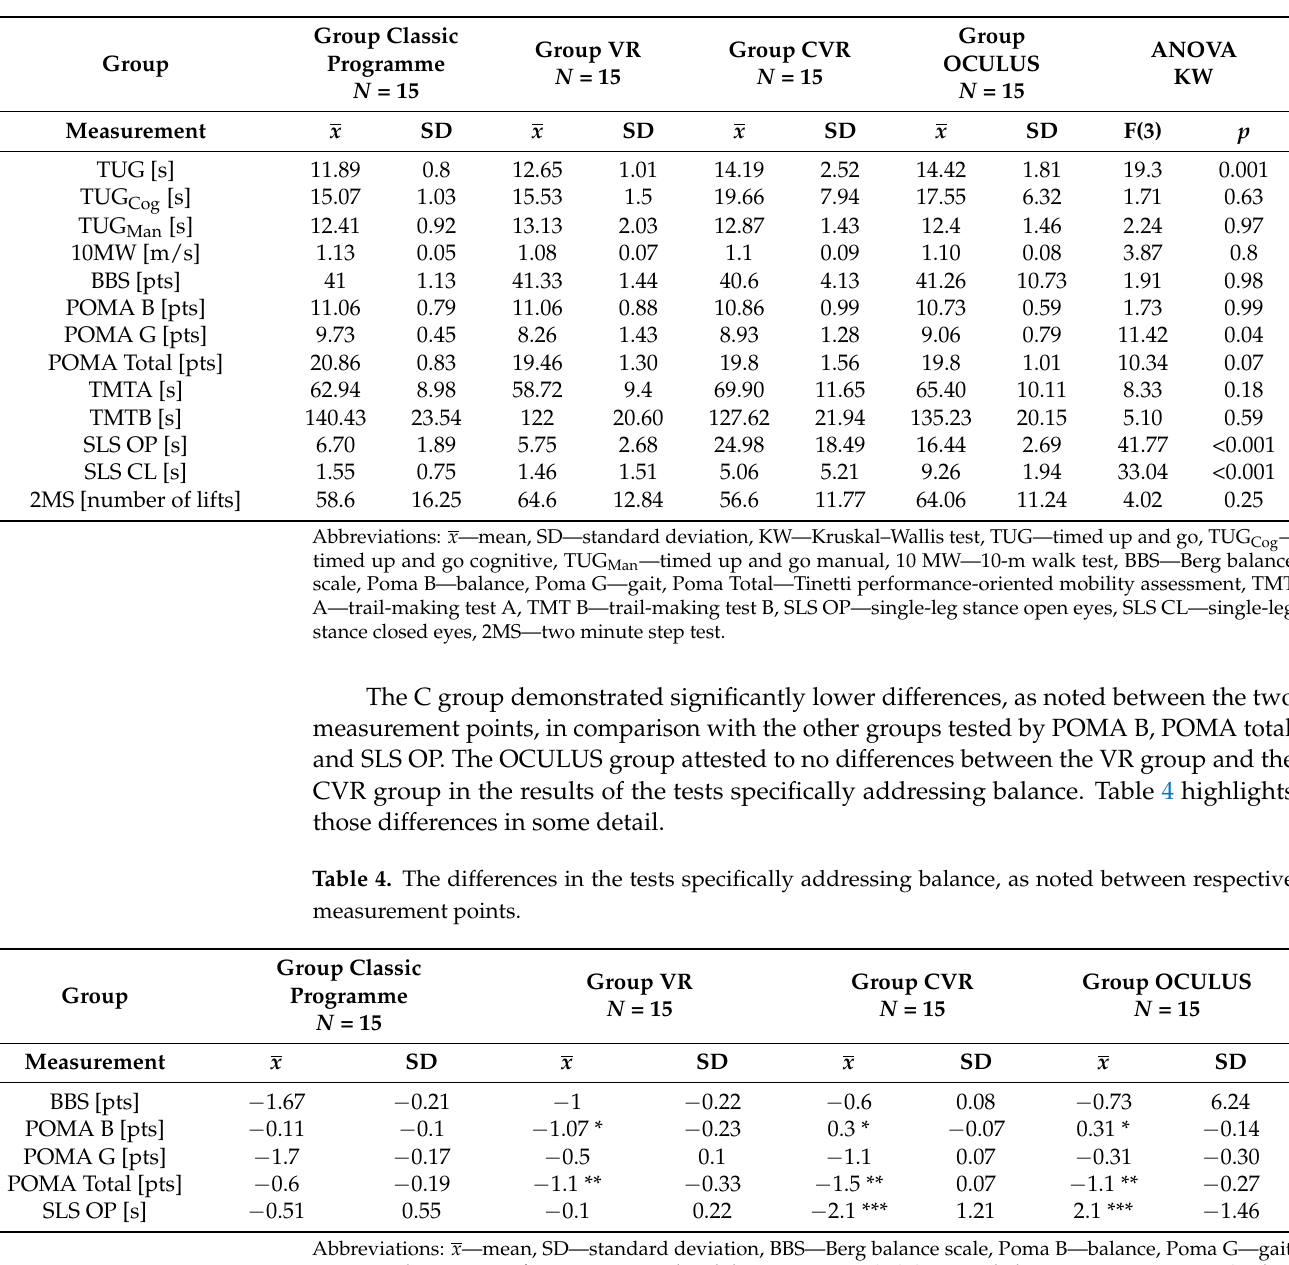
Table 3. Functional performance per respective study groups, as noted at the Second Measure- ment Point.